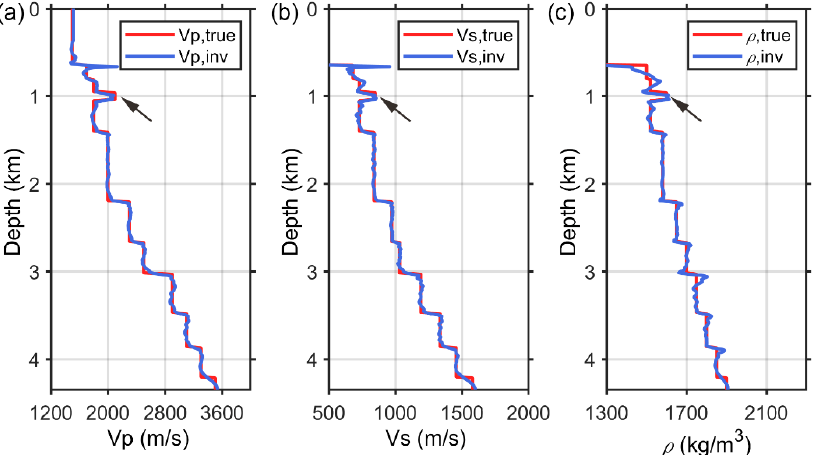
Figure 11. Comparison between the true model at 2.25 km and the inverted model from the noise-free data using the wave-equation-based inversion method: ( a ) P-wave velocity, ( b ) S-wave velocity, and ( c ) density. The black arrow indicates the location of the gas hydrate reservoir.